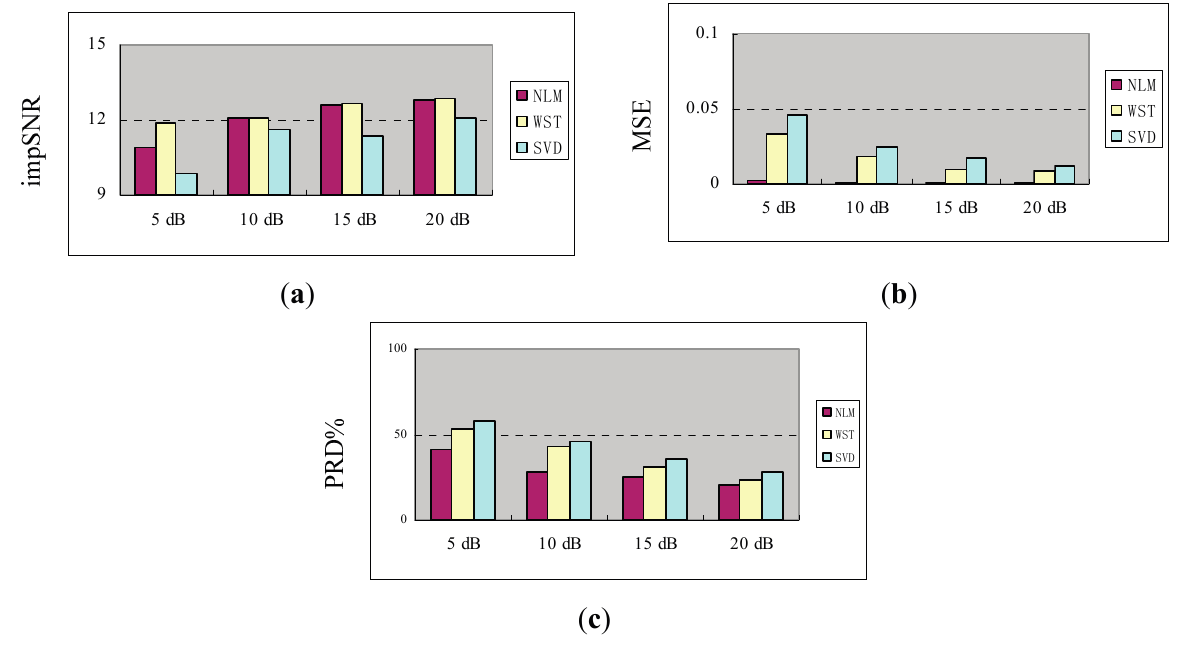
Figure 6. impSNR ( a ), MSE ( b ) and PRD% ( c ) of the simulated fault signals. WST, wavelet soft thresholding; SVD, wavelet soft thresholding method.